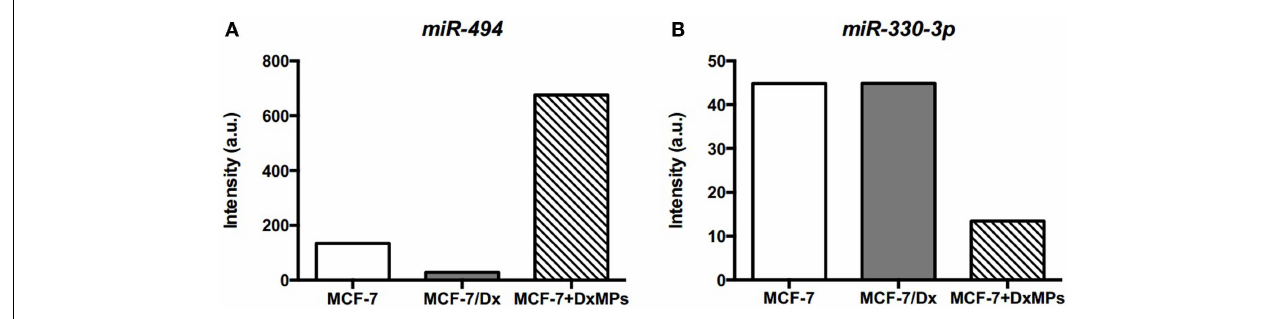
FIGURE 7 | Expression of miRNAs as determined by microarray analysis . Expression levels of (A) miR-494 and (B) miR-330-3p in cells. Microarray expression levels of miRNAs in ( ): MCF-7 cells, ( ): MCF-7/Dx cells, and ( ): MCF-7 cells co-cultured with